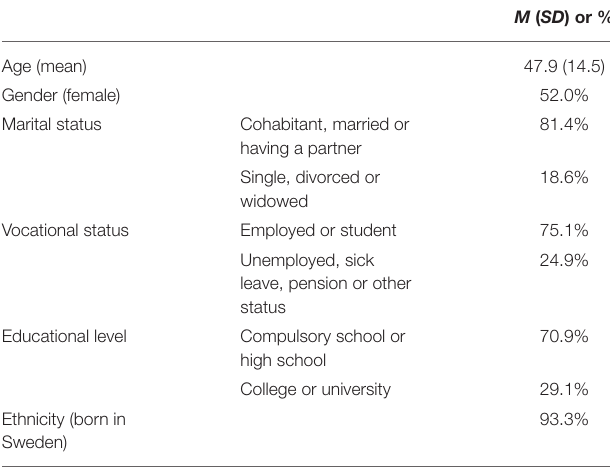
TABLE 1 | Study participants ( N = 1,670): descriptive